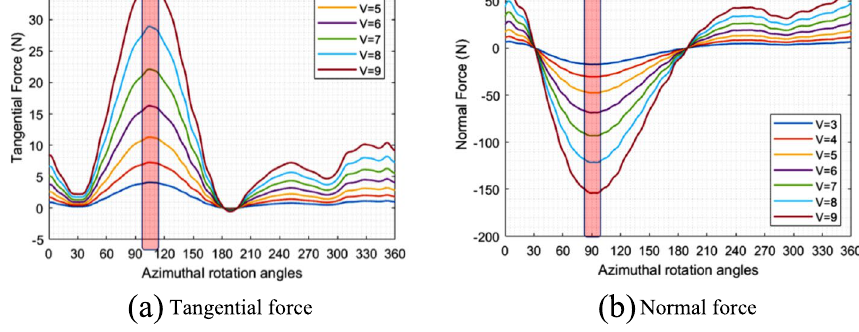
Fig. 3 Aerodynamic load fluctuations